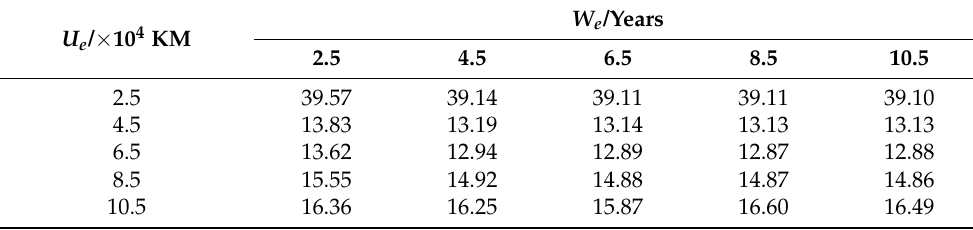
Table 7. The EW cost (unit: 10 4 CNY/year).